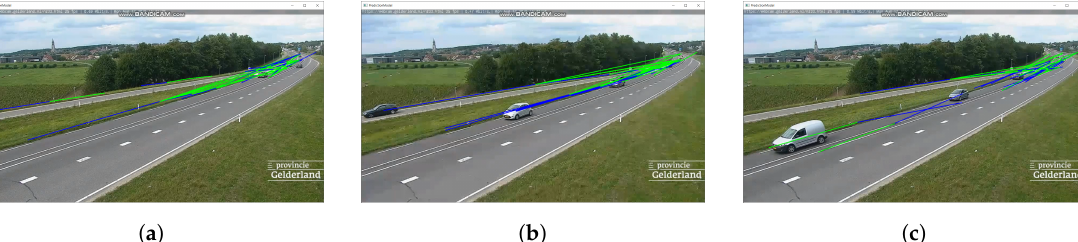
Figure 13. Prediction model visualizing the driving paths on a highway in the Netherlands. Request intervals are 500 ms in ( a ), 1000 ms in ( b ) and 1500 ms in ( c